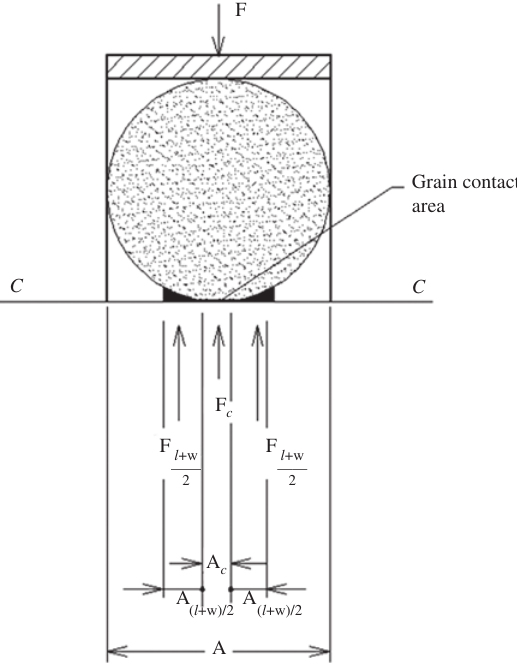
Figure 7 Schematic of load-bearing cross-sectional